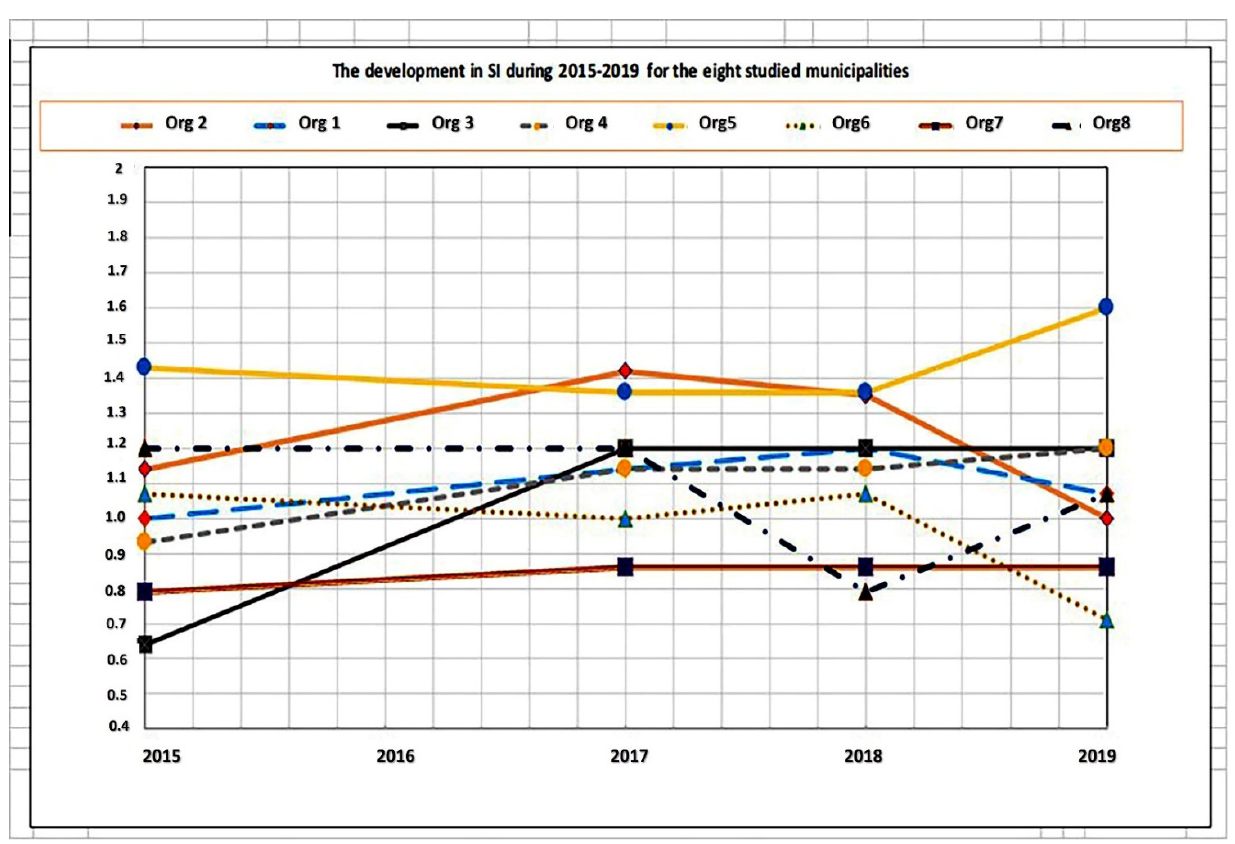
Figure 10. Alteration trend for SI parameters during 2015 and 2017–2019 for Orgs. 1–8.